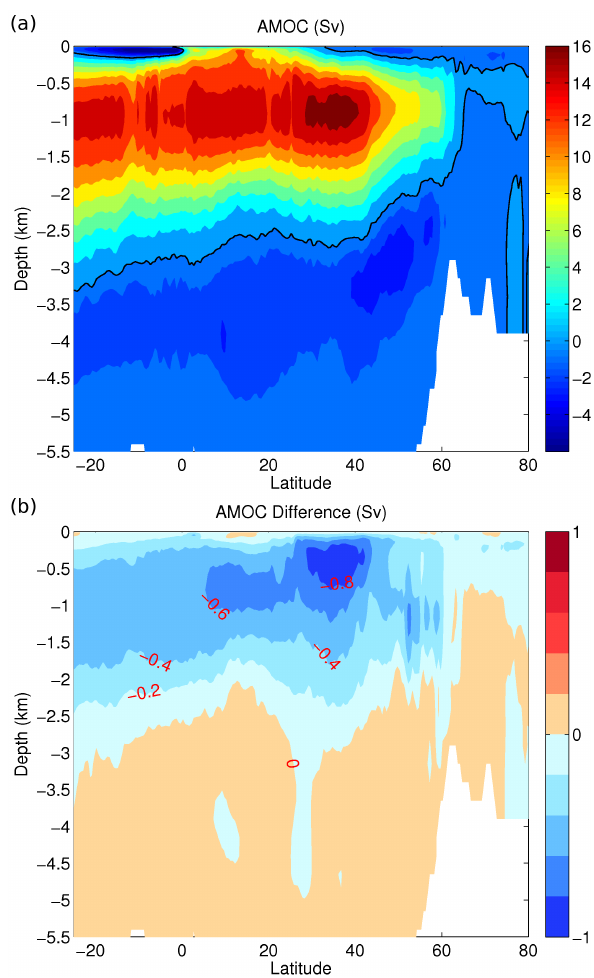
Fig. 10. (a) Atlantic Meridional Overturning Circulation (AMOC) Fig. 110. (a) Atlantic Meridional Overturning Circulation (AMOC) stream function (Sv) in a run without parametrized mixing due to streamfunction (Sv) in a run without parameterized mixing due to barotropic tides and (b) the difference from a run with the tidal mix- barotropic tides and (b) the difference from a run with the tidal mix- ing. The results are the last 10yr mean in 60yr simulations. ing. The results are the last 10 yr mean in 60 yr simulations.